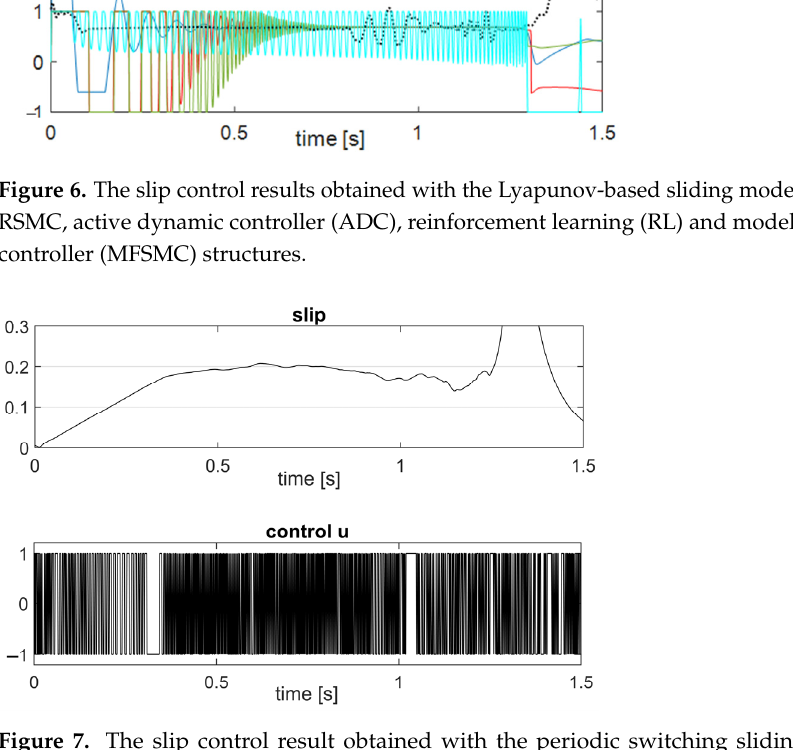
Figure 7. The slip control result obtained with the periodic switching sliding mode controller (PSSMC) structure.